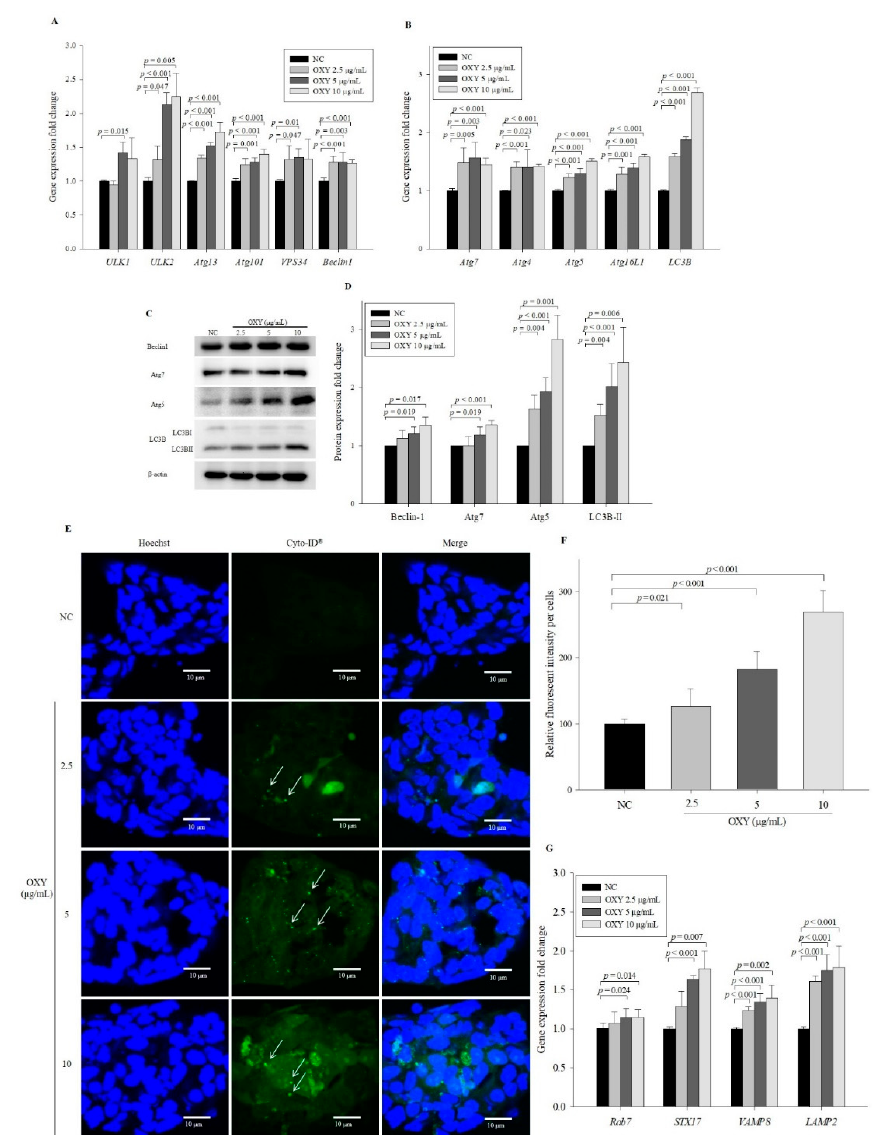
Figure 3. E ff ect of OXY on the expression levels of autophagy-related genes and proteins. Expression levels of genes related to phagophore formation were quantified by qPCR ( A ). Expression levels of autophagosome elongation-related genes were quantified by qPCR ( B ). Expression levels of autophagosome formation-related proteins were measured by Western blotting ( C ) and quantified ( D ). From each lysate, equal amounts of protein were loaded on a separate gel, blotted for actin and this signal was used for determining the ratio of the protein of interest / actin as displayed in the figure. The cropped blots are representative of three independent experiments. The full-length blots are shown in Supplementary Figure S2. The e ff ect of OXY on autophagic vesicle formation was measured by staining with a fluorescence dye using a CYTO-ID autophagy detection kit; white arrows indicate autophagosomes (magnification 600 × ) ( E ), which were quantified ( F ). Expression levels of autolysosome formation-related genes were quantified by qPCR ( G ). Each value indicates the mean ± SD of three independent experiments performed in